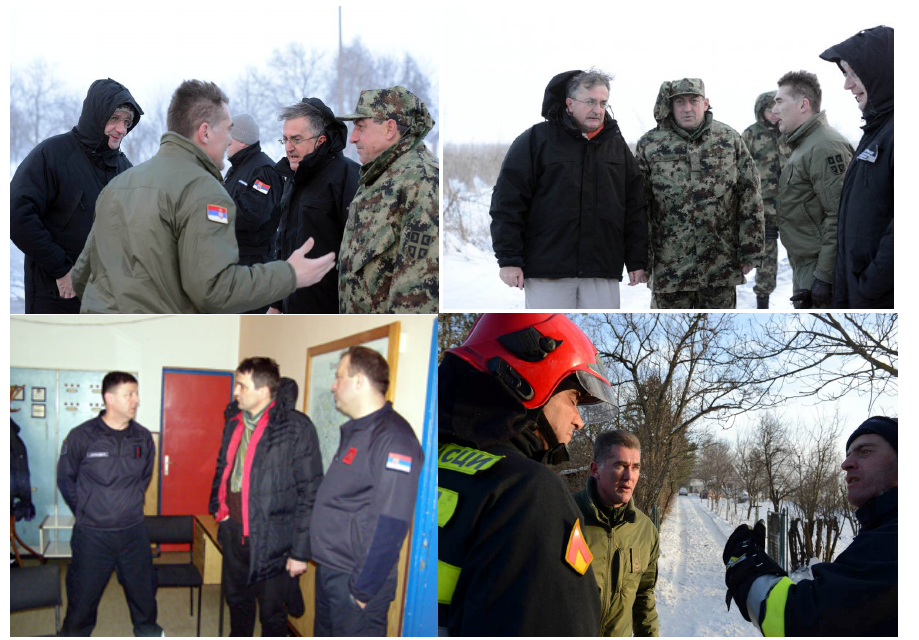
Figure 9 – Coordination in the field: JSL, MO-The Serbian Army, Department of VS